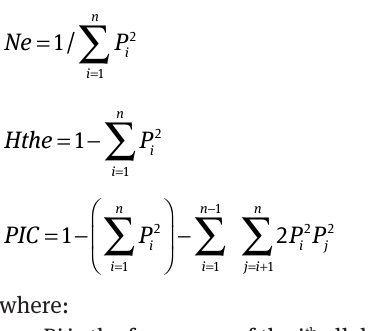
Figure 1B. Digested fragments were run through an ethidium bromide (1 μgmL -1 ) 3% (w/v) agarose gel (Sigma-Aldrich, Steinheim, Germany) with 1x TBE